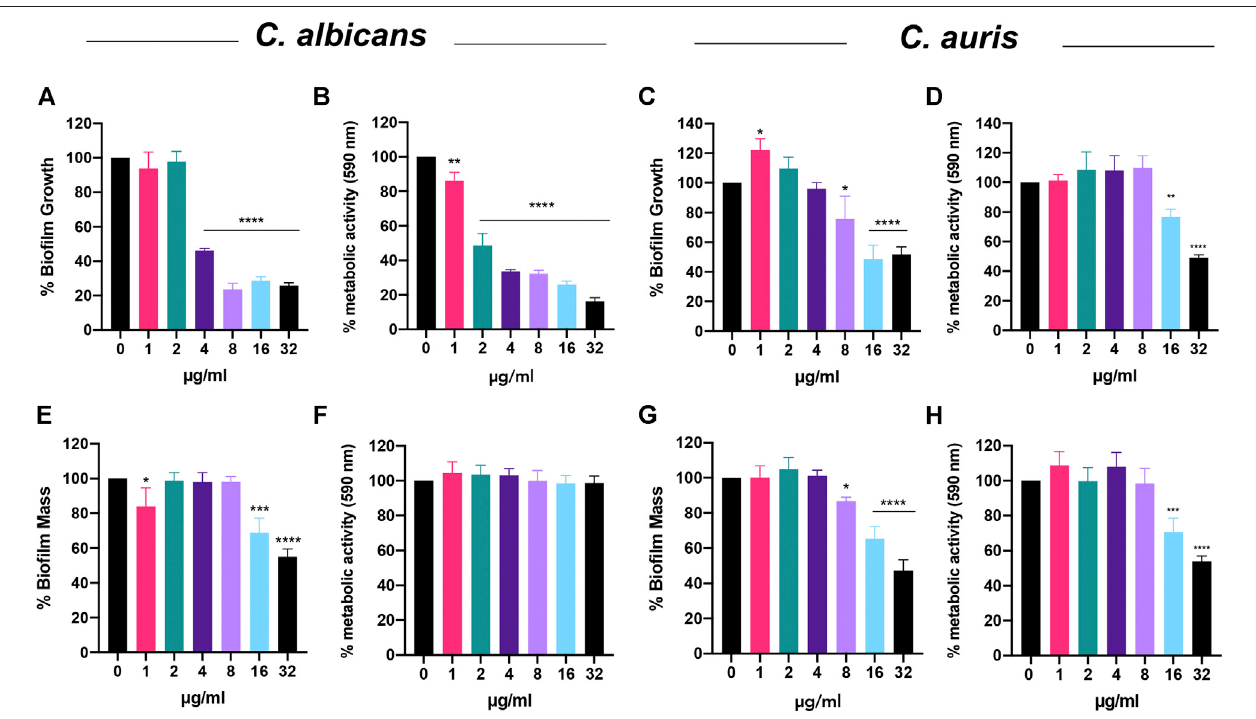
FIGURE 5 | Bay 11-7085 shows anti-bio fi lm activity toward three phases of C. albicans and C. auris bio fi lm maturation. Ef fi cacity of Bay 11-7085 was measured against C. albicans strain SC5314 and C. auris strain #0384 bio fi lm inhibition and eradication. Total biomass was measured using 1% crystal violet (CV). Metabolic activity was measured using XTT (590 nm). Inhibition of C. albicans bio fi lm formation by various concentrations of Bay 11-7085 as measured by (A) 1% CV and (B) XTT dye.Inhibitionof C.auris bio fi lmformationbyvariousconcentrationsofBay11-7085asmeasuredby (C) 1%CVand (D) XTTdye. C.albicans bio fi lmeradicationas measured by (E) 1% CV, and (G) XTT dye. C. auris bio fi lm eradication as measured by (G) 1% CV and (H) XTT dye. X-axis represents concentrations of Bay 11-7085 in µg/ml. Statistical signi fi cance was determined using one-way ANOVA with Dunnett ’ s test for multiple comparisons. * p < 0.05; ** p < 0.01; *** p < 0.001; **** p < 0.0001. ( n (cid:2) 3, ±